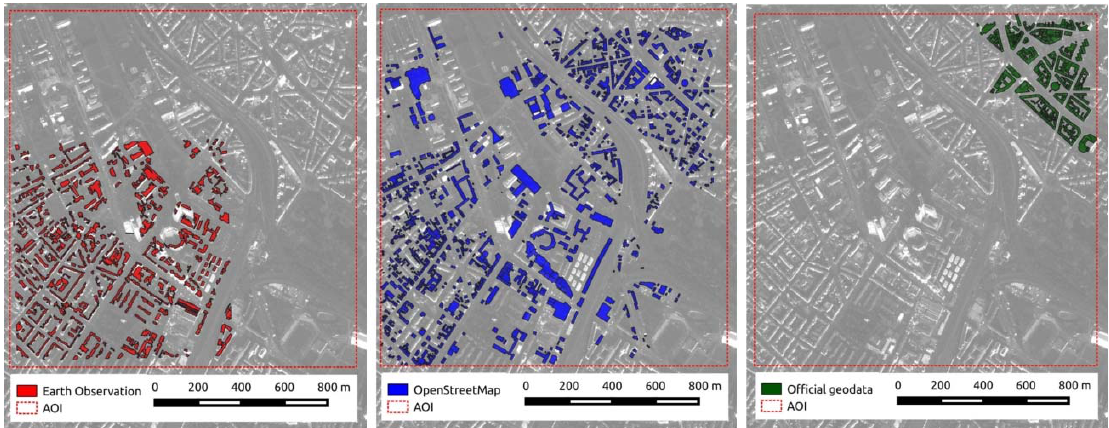
Figure 5. Scenario Area of Interest (AOI) with the different sources for creating a unified building